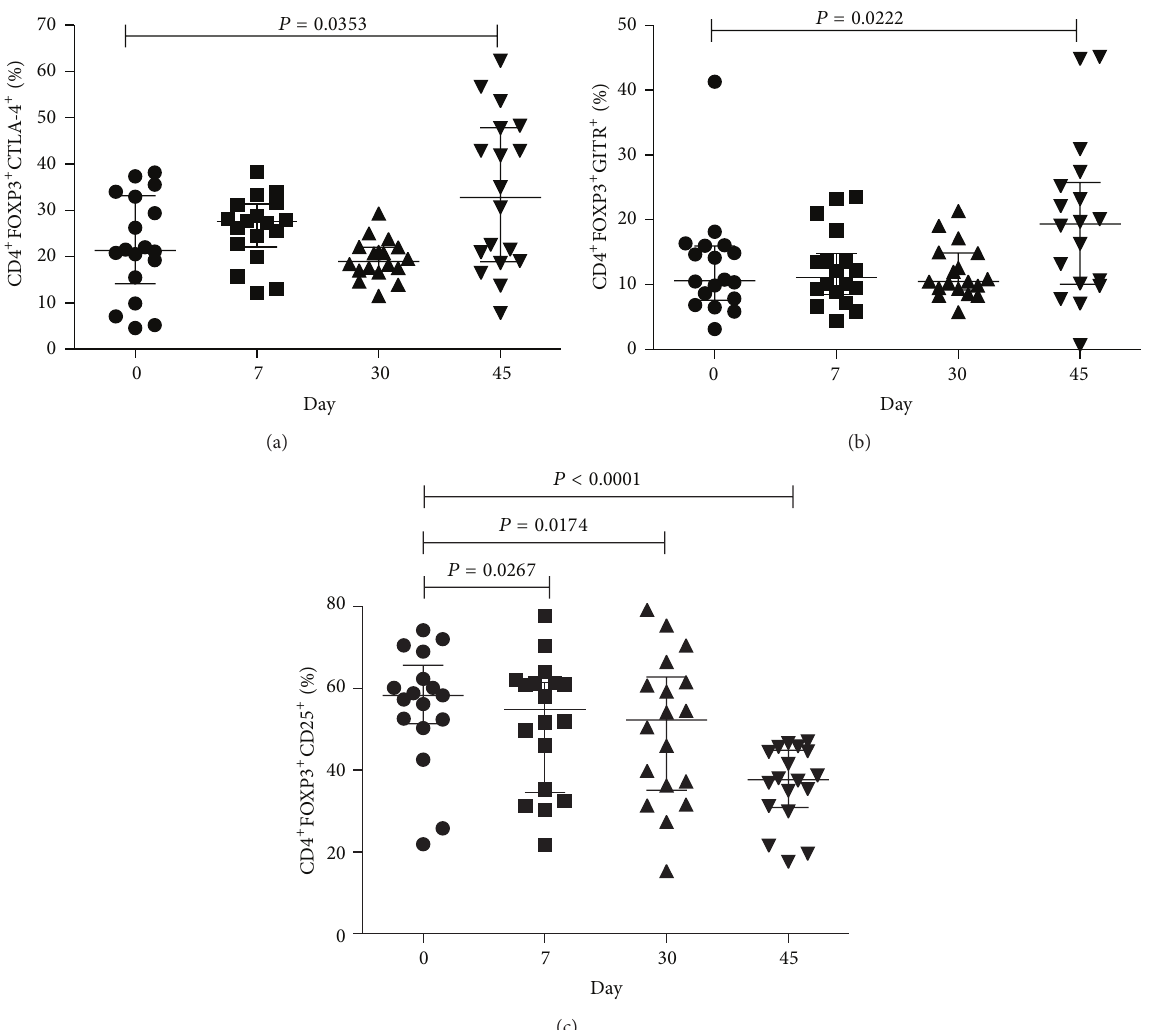
Figure 2: Statins increased the expression of Treg markers. Multiparameter flow cytometric analysis of percentage of CD4 + FOXP3 + Treg expressing CTLA-4 (a), GITR (b), and CD25 (c). Median, interquartile range (IQR), and 𝑃 values are shown in the graph; difference between days was tested by Wilcoxon signed-rank